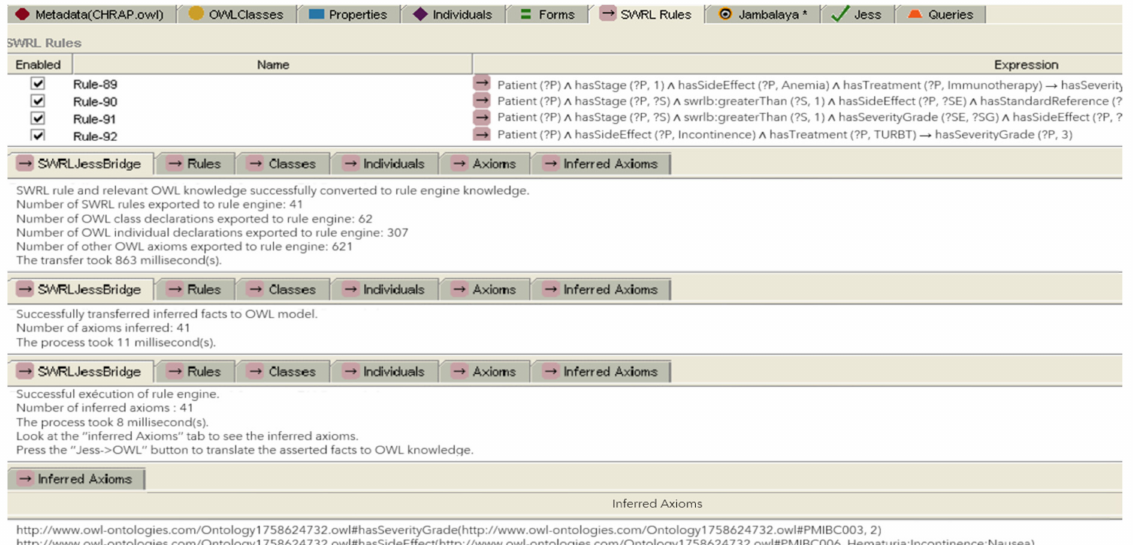
Figure 7. Results and validation of Jess and axioms inferences.